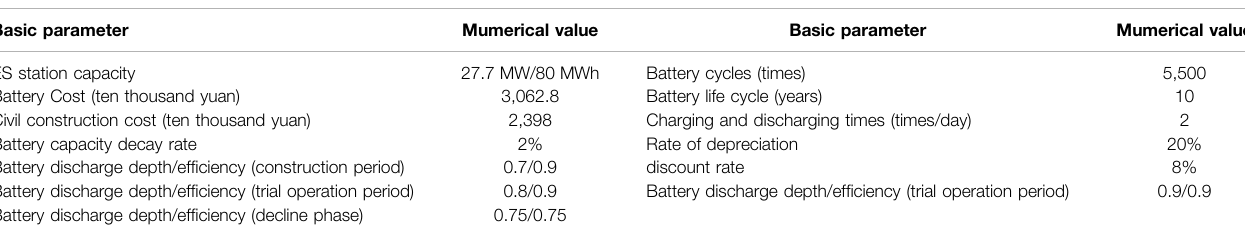
TABLE 1 | Basic parameters of an ES battery. Basic